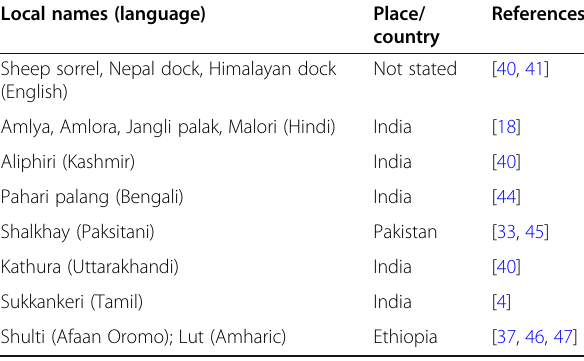
Table 1 Vernacular names of R. nepalensis Local names (language) Place/